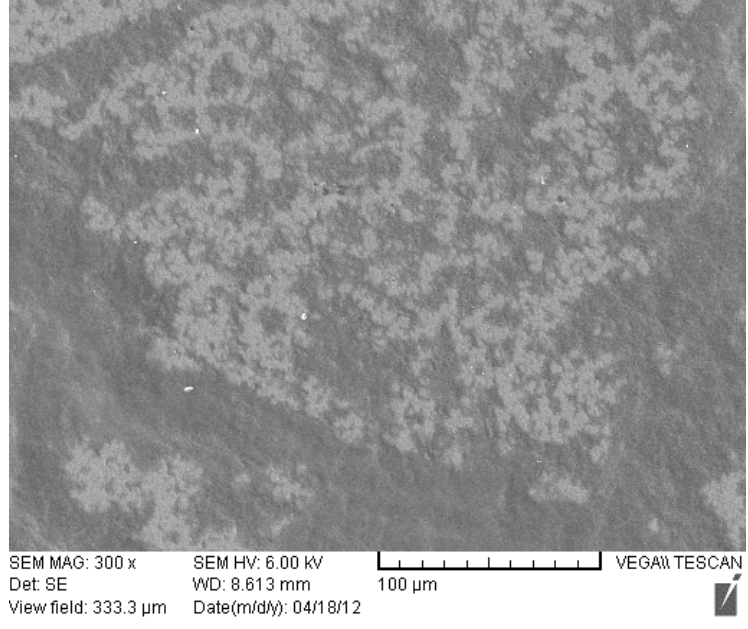
Figure 2. Representative scanning electron microscopy (SEM) image from a sample set of multilayer films with the general composition of CHI/HA shows a rough but continuous film with no pores for a multilayer film made with SA